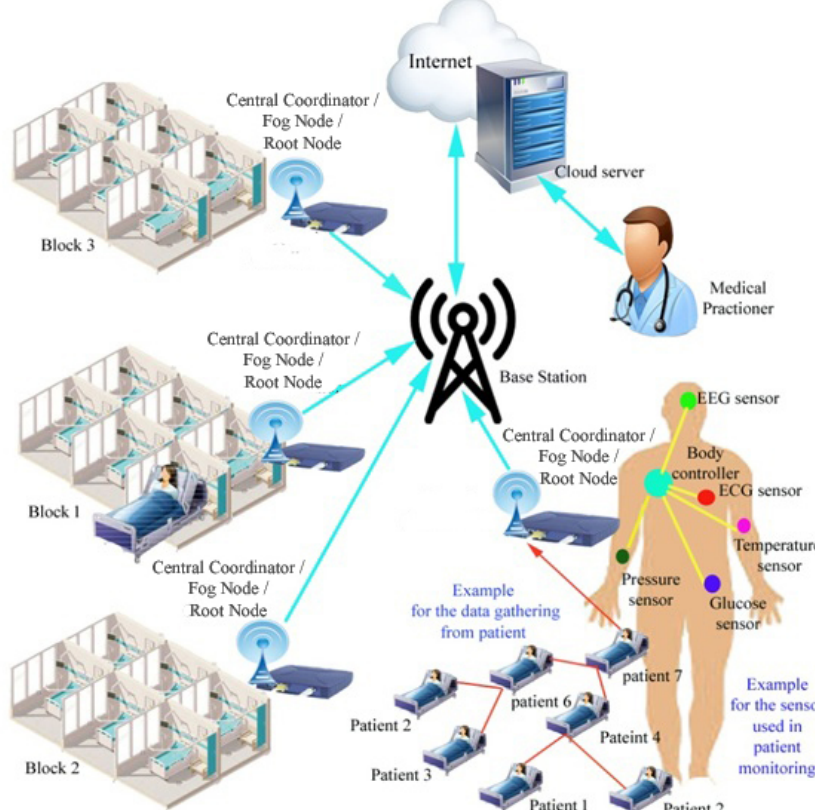
Figure 1. Fog-assisted architecture for in-hospital health